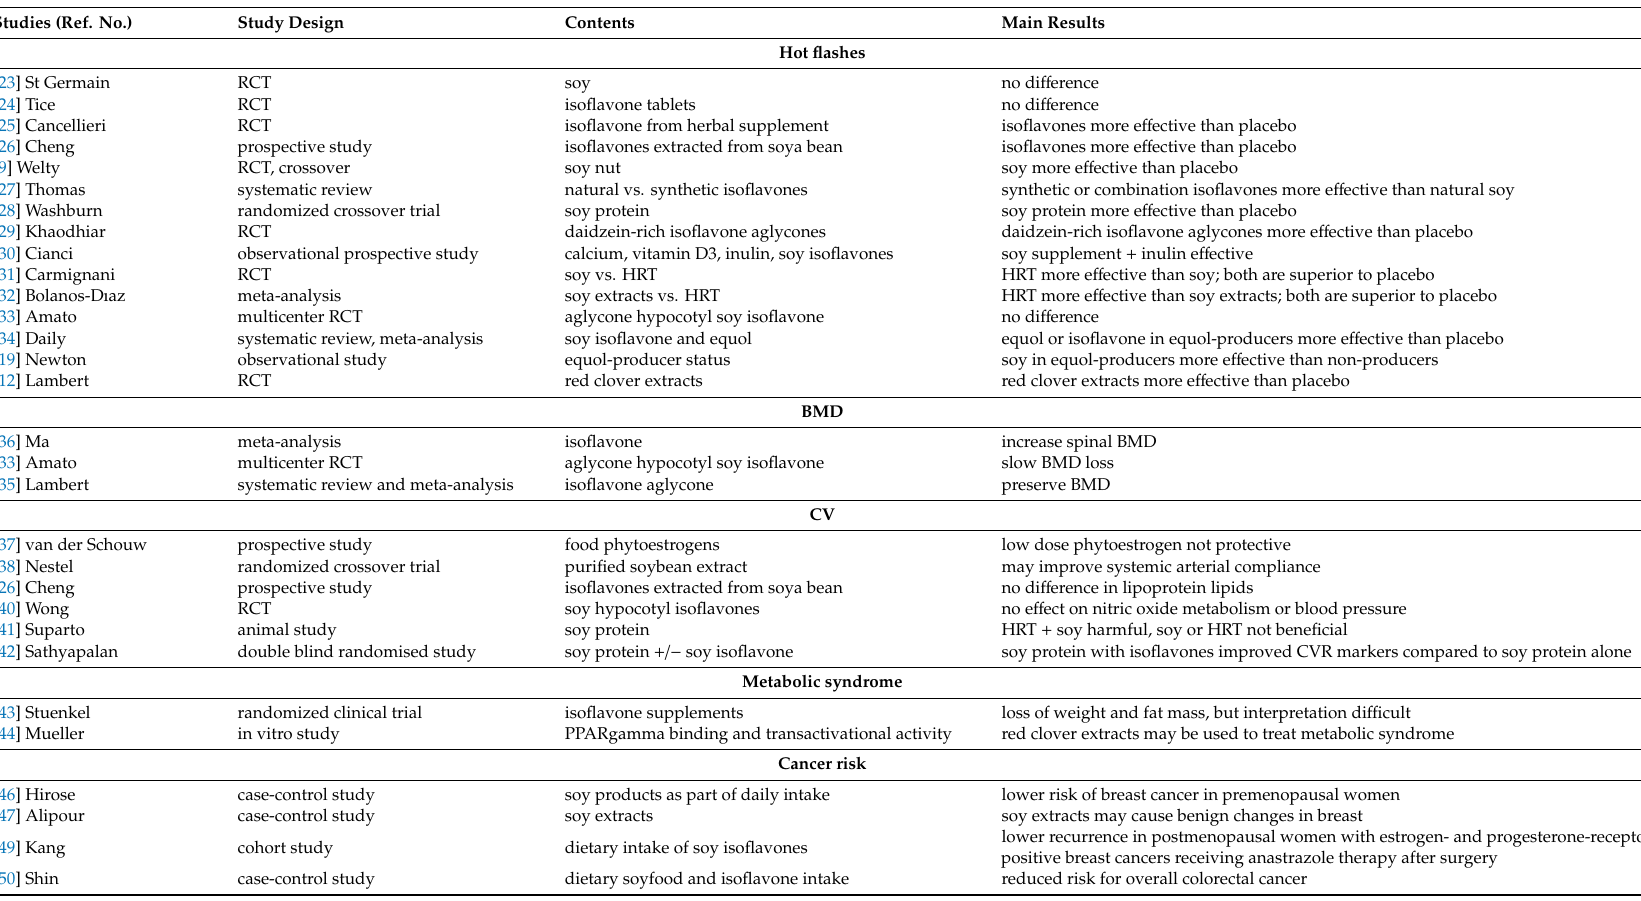
Table 1. A brief summary of current evidence of studies regarding the e ff ects of isoflavones. Bone mineral density (BMD), hormone replacement therapy (HRT). Studies (Ref.